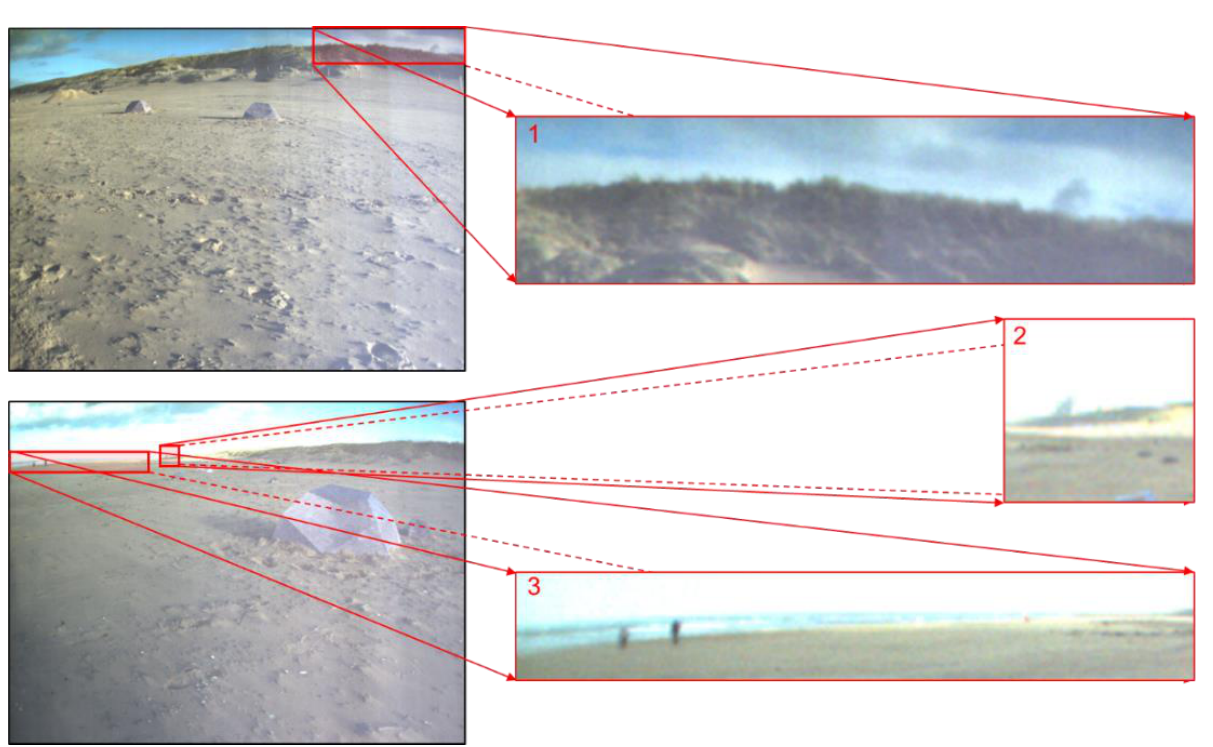
Figure 6. The difficult sample regions for manual annotation in the Katwijk beach planetary rover dataset. The red frames highlight the difficult sample regions. “1” refers to a broken edge, which has a very complicated structure. “2” refers to a rock target, which is difficult to identify the skyline part. “3” refers to a high reflection target, and its skyline part is also difficult to identify.